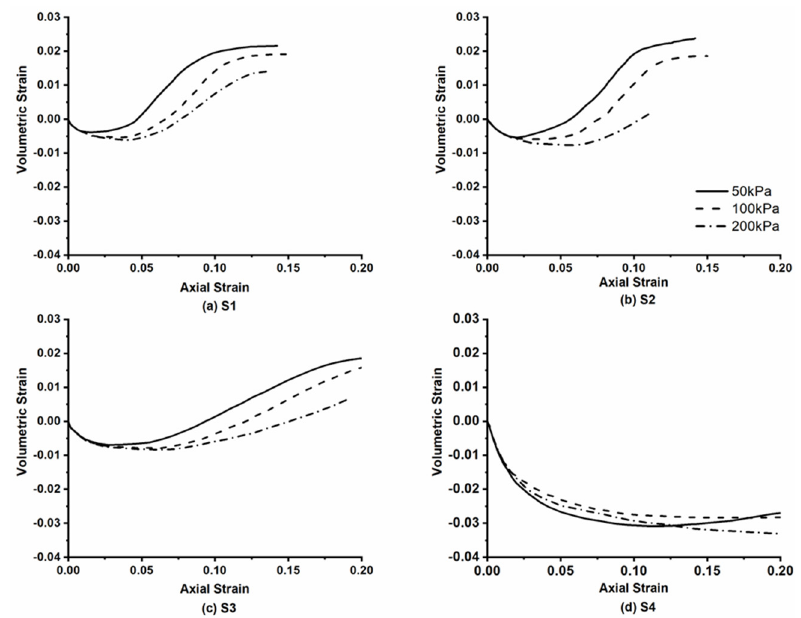
Figure 6. Volumetric strain versus axial strain for TDA-sand mixtures with 5%, 10%, 30%, and 50% TDA by weight at confining pressures of 50 kPa, 100 kPa, and 200 kPa.